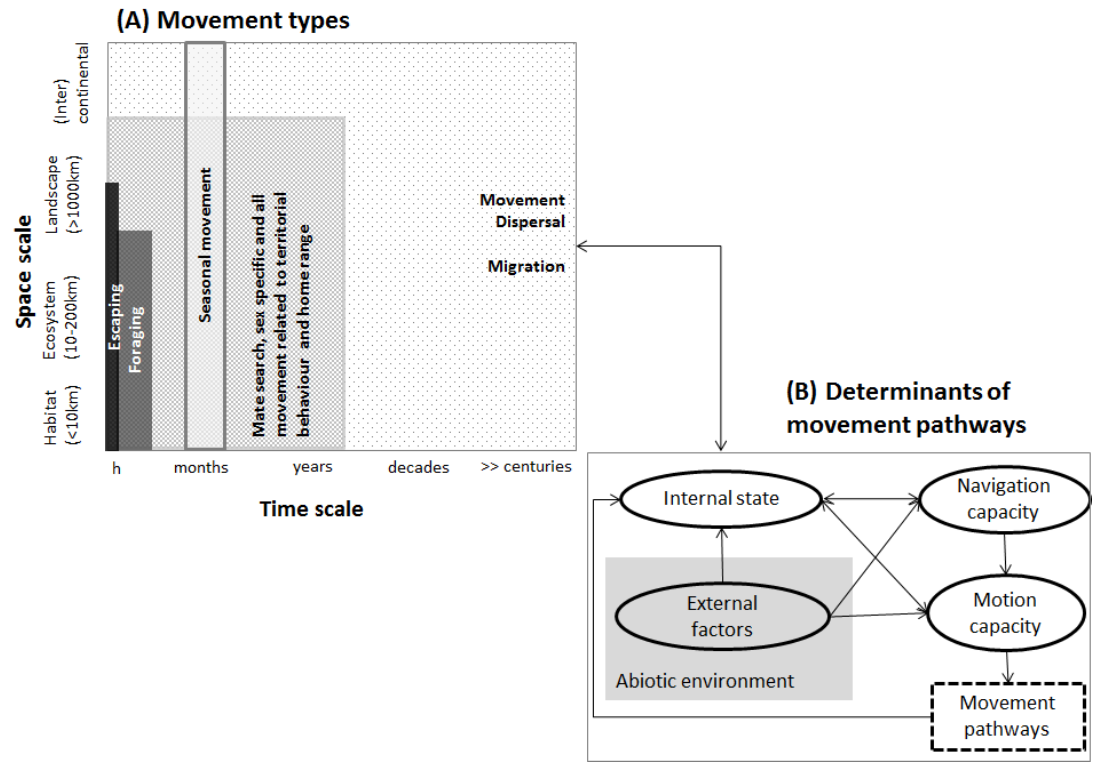
Figure 2. ( A ) Movement types and ( B ) determinants of movement pathways (simplified from Nathan et al. [42] ). Nathan et al.